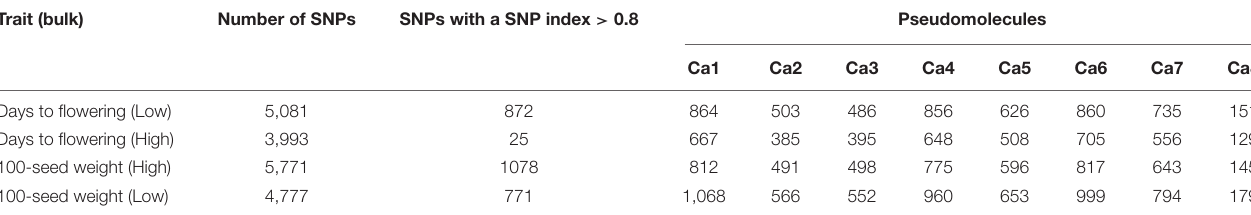
TABLE 2 | Identification and distribution of associated SNPs in the genome.